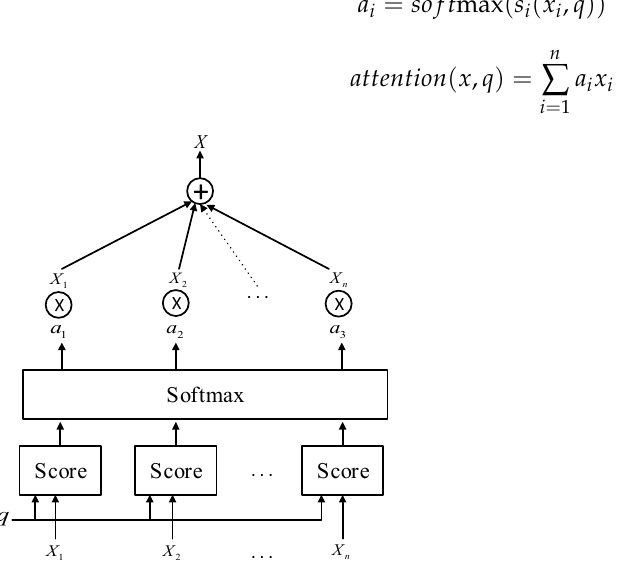
Figure 11. Attention model structure.